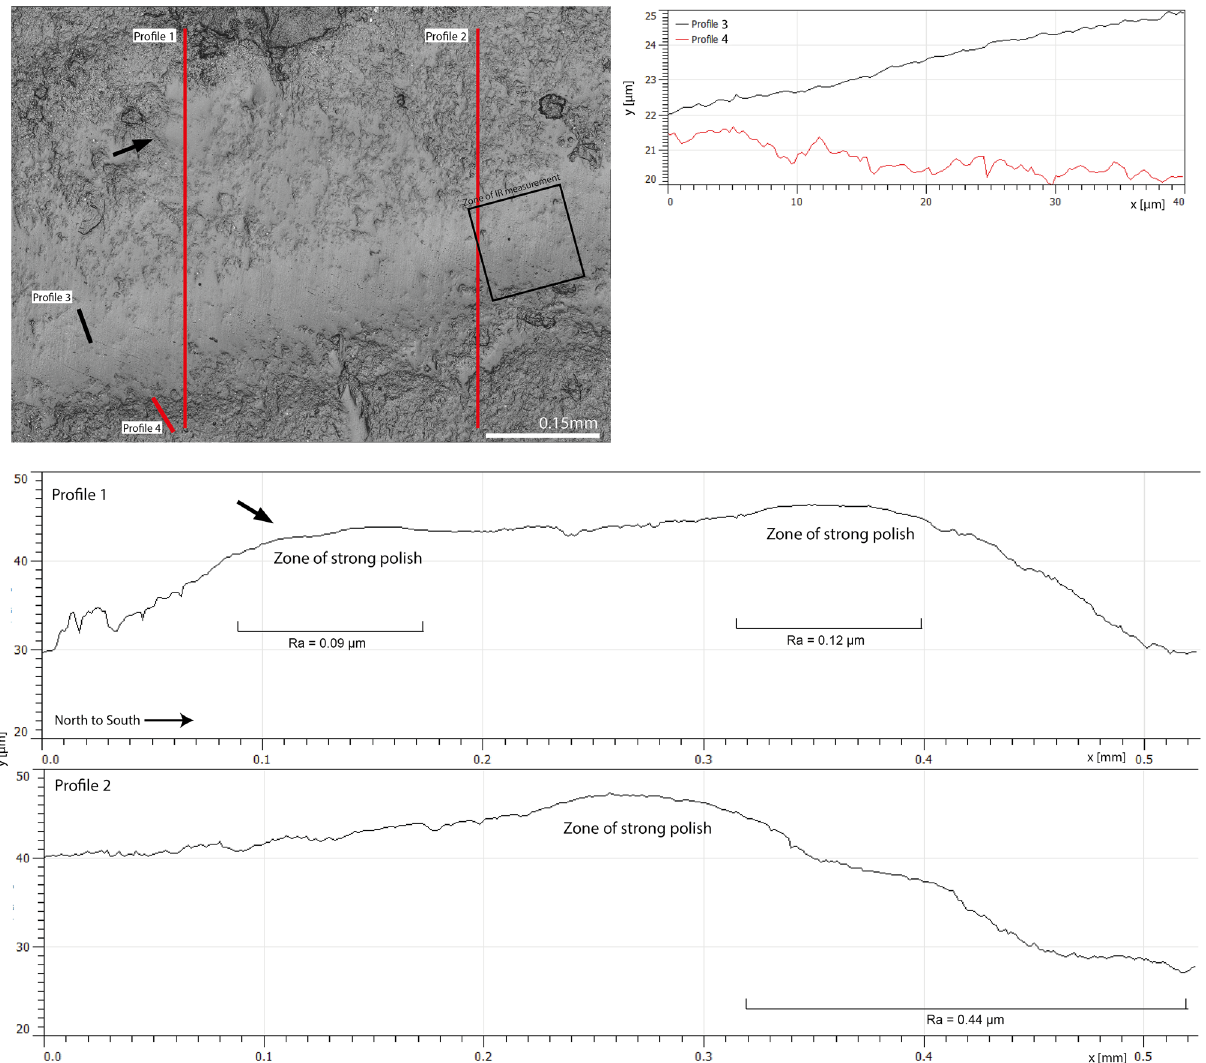
Figure 5. 3D surface model of chert abraded against spruce wood and the corresponding extracted profiles. Note the stronger roughness in unpolished zones. Also note that the higher parts are more polished than the valleys. The zone indicated by a black arrow in the picture is the zone pointed out by the same arrow in profile 1. Rendered with Gwyddion v. 2.4., http://gwydd ion.net/ 32